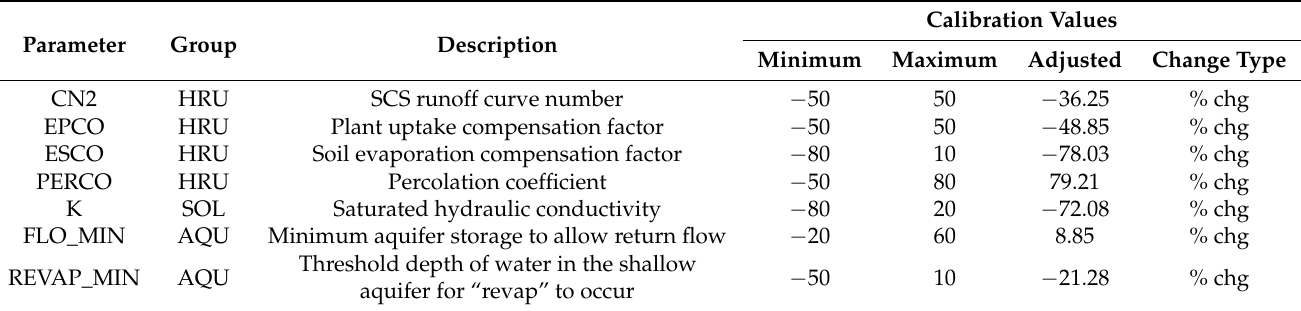
Table 5. Parameters used for the SWAT+ calibration model with SWAT+